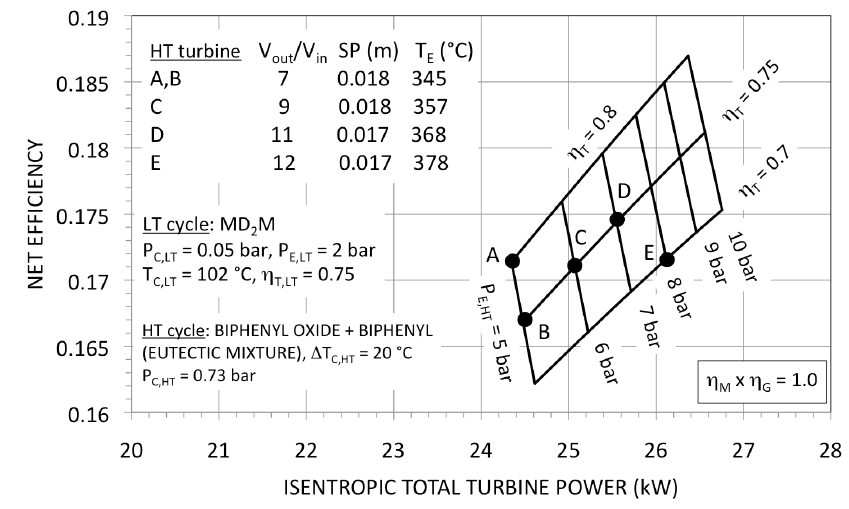
Figure 9. Net cycle efficiency and isentropic turbine power for binary cycles. Working fluids: MD 2 M for the bottoming (LT) cycle; a eutectic mixture for the topping one.